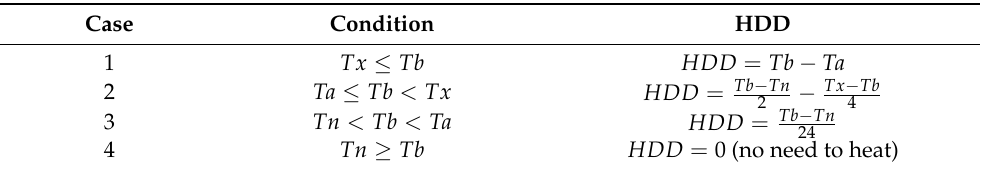
Table 2. Calculation of daily HDD values by comparing the maximum and minimum temperatures relative to the base temperature (Tb) [11,16].